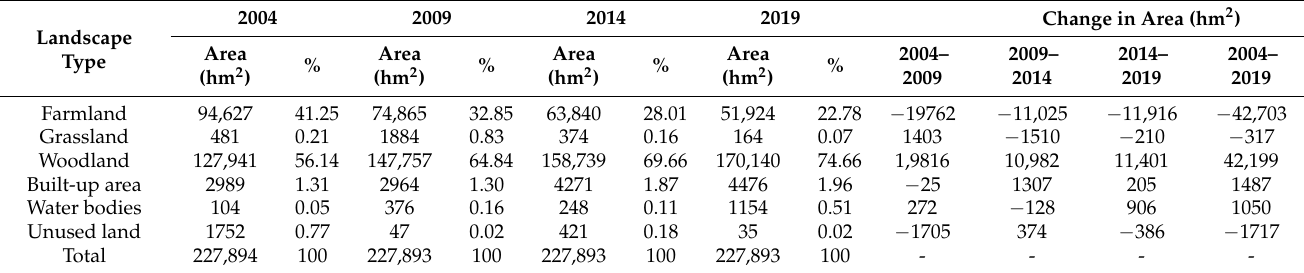
Table 5. Land area change and its respective percentage of each class of LULC during the study period (2004–2019). Landscape Type